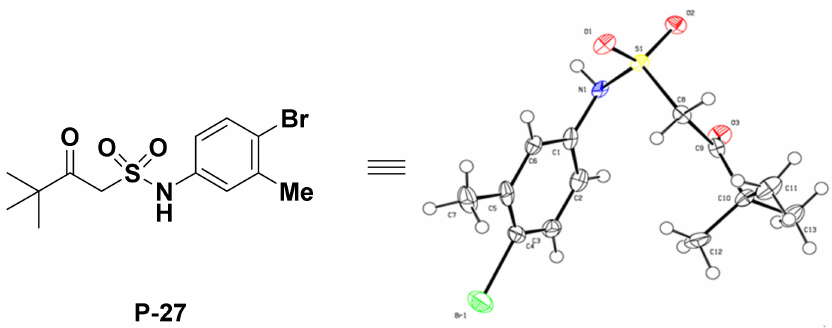
Figure 4. X-ray single crystal diffraction of compound P-27